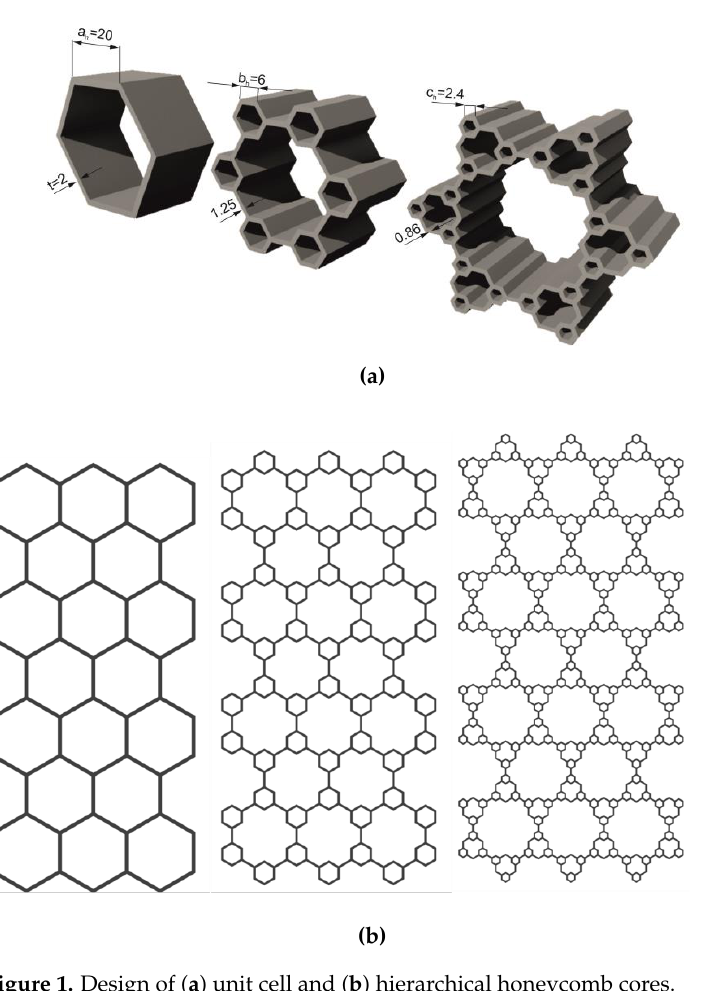
Figure 1. Design of ( a ) unit cell and ( b ) hierarchical honeycomb cores.